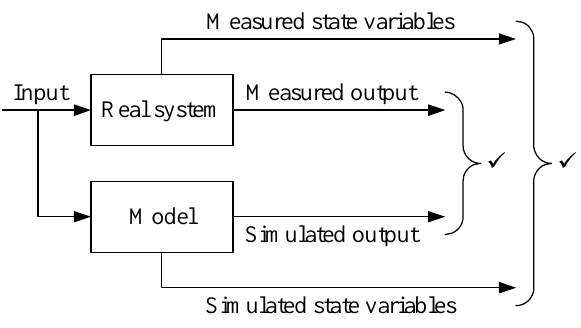
Figure 11: Principle of model